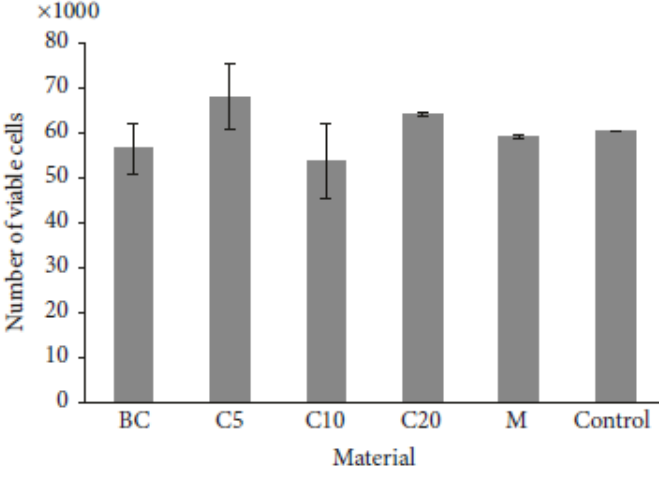
Figure 2. Number of viable rMSCs afer 72 h of growth onto BC-PHEMA hydrogels determined by